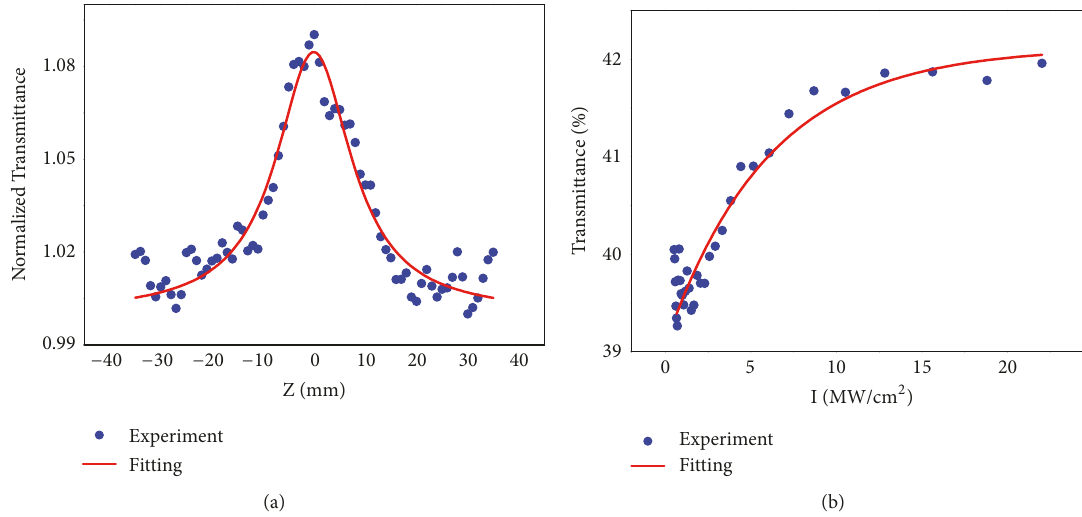
Figure 2: The experimental data of the nonlinear transmittance of the MoTe 2 .